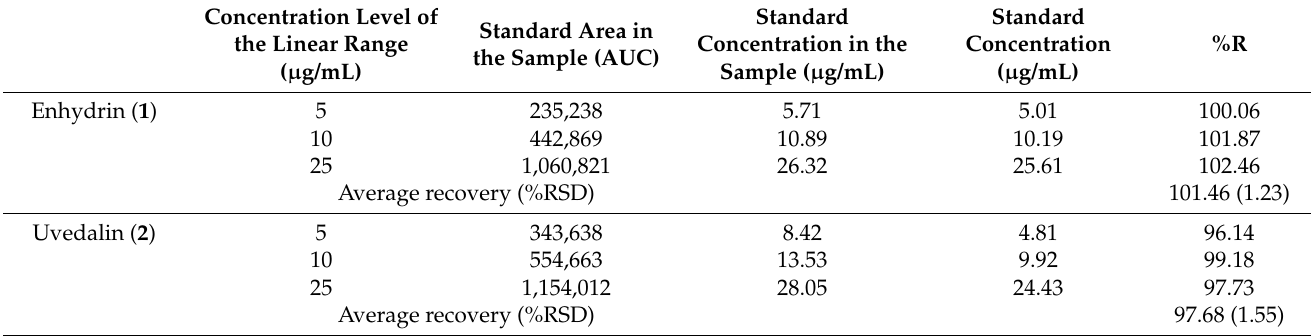
Table 4. Data on the HPLC method’s accuracy for the compounds 1 and 2